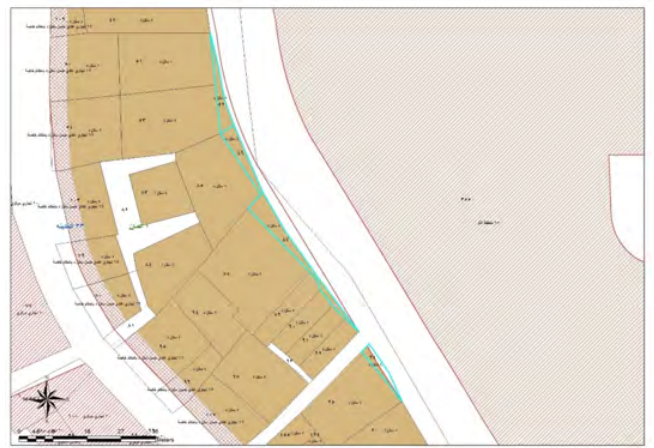
Figure 3. Land bit land-use map. Source: GAM- GIS for the author (2016).